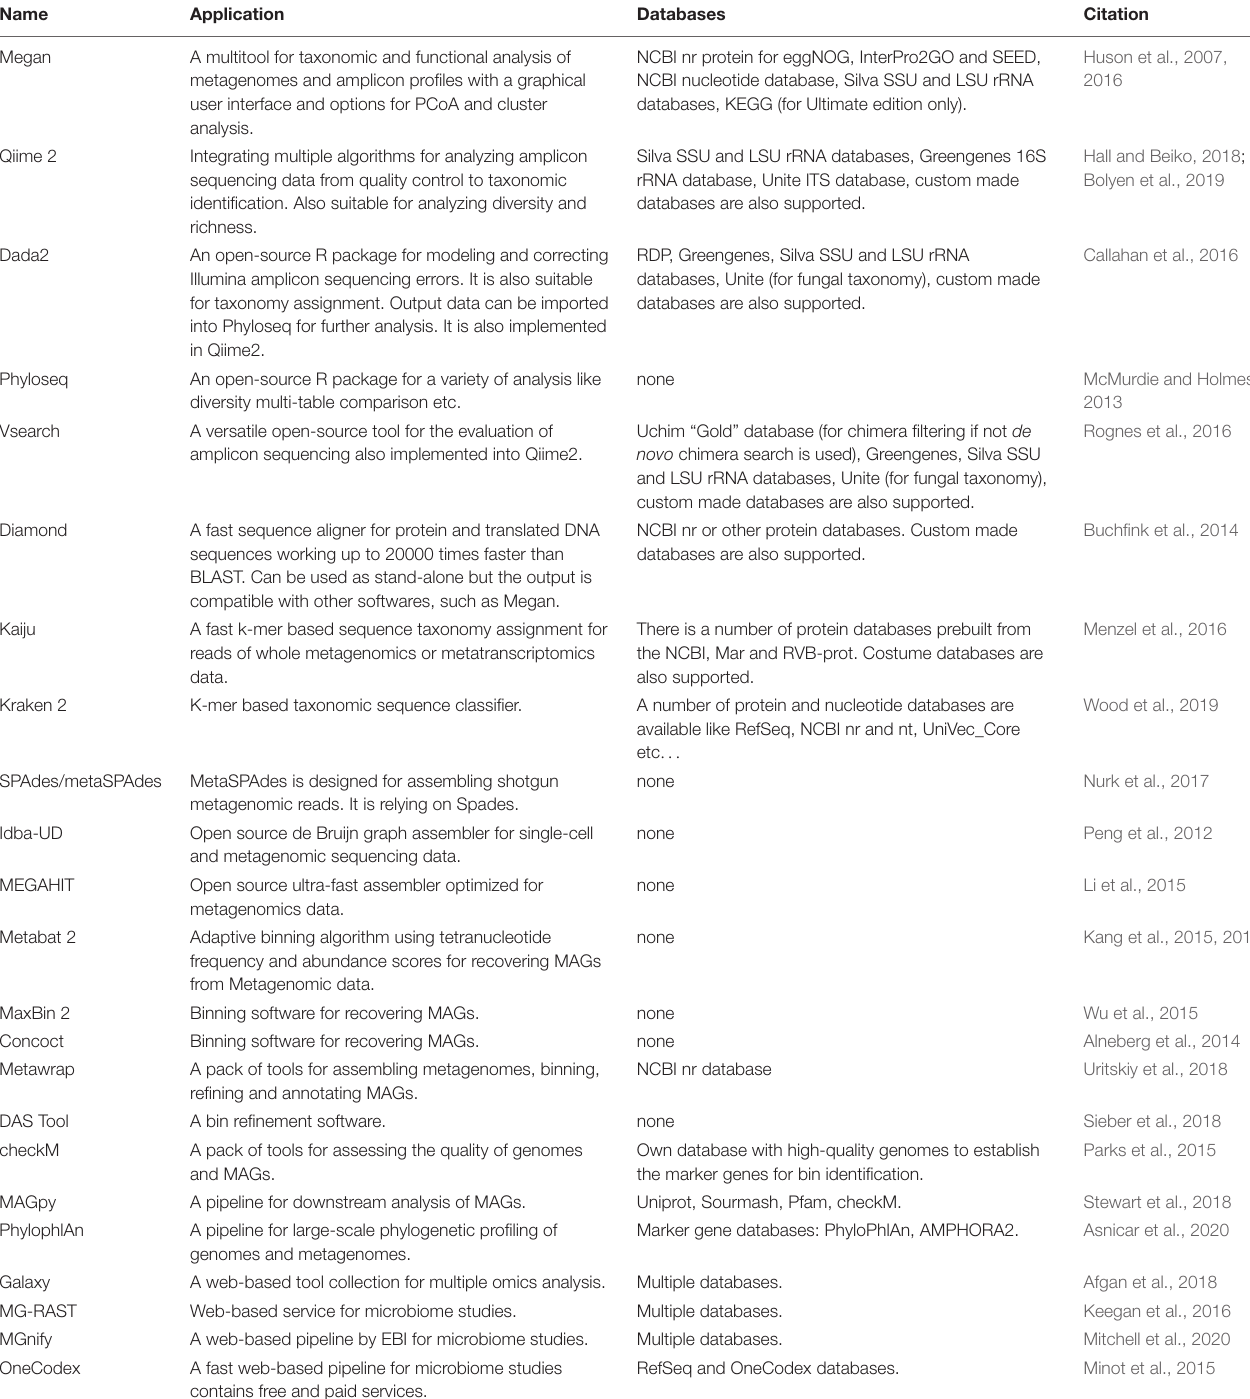
TABLE 2 | Bioinformatic tools used in the multi-omics